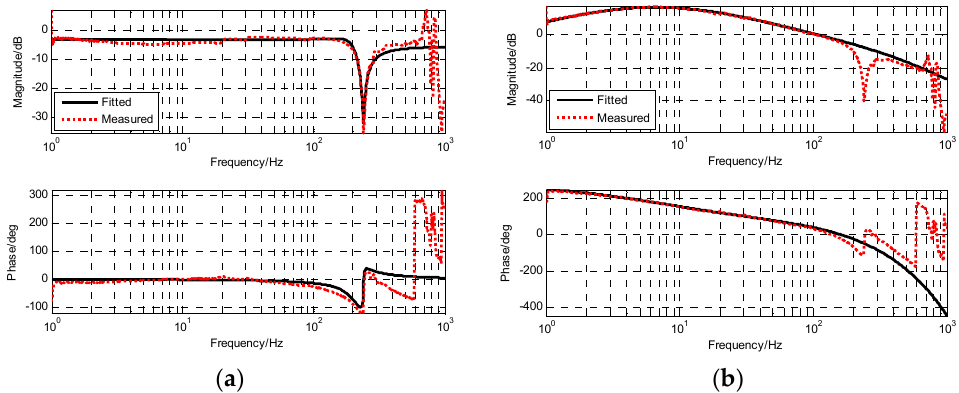
Figure 17. The frequency characteristics of OTT based on closed-loop fusion with optimal design: ( a ) The resonance response of platform; ( b ) The open-loop frequency response of platform.